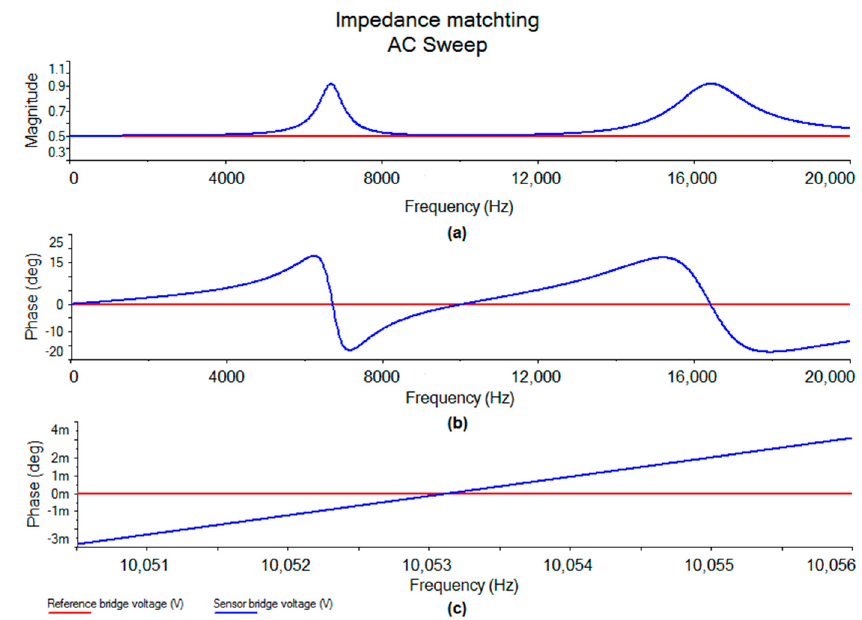
Figure 25. Simulation of an AC sweep across a balanced modified Wheatstone bridge showing ( a ) magnitude; ( b ) phase and ( c ) magnified phase at 10 kHz vs. applied AC frequency.